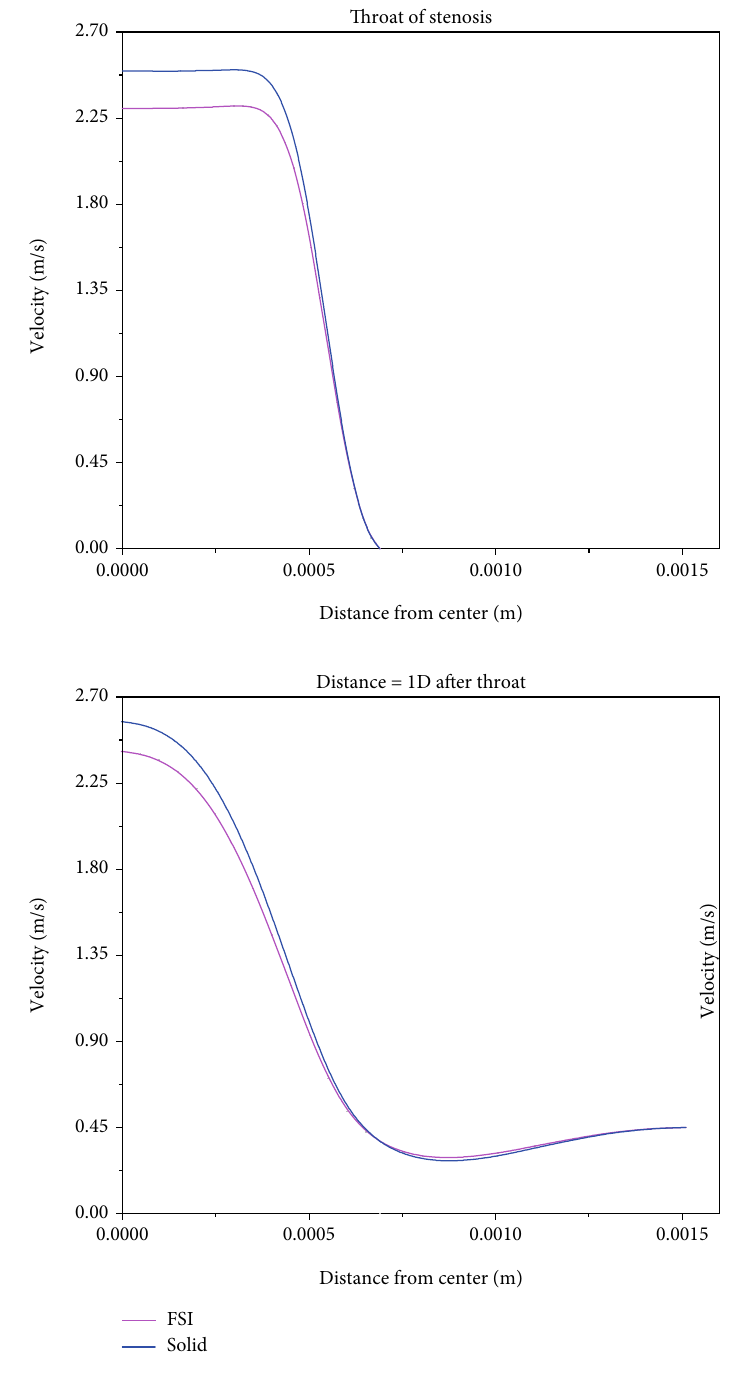
Figure 7: Comparing the velocity pro fi le between the rigid and elastic walls for simple